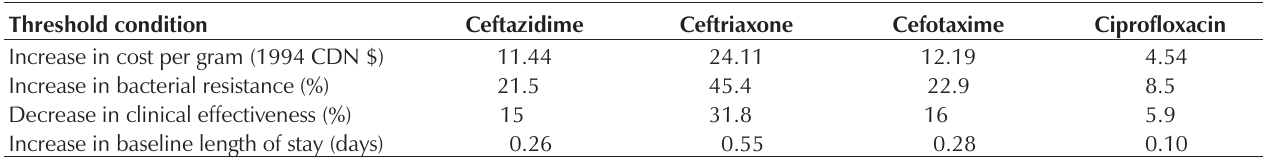
TABLE 9 Threshold change for alternative antibiotics to result in equivalent cost with cefepime for the average weighted infectious disease